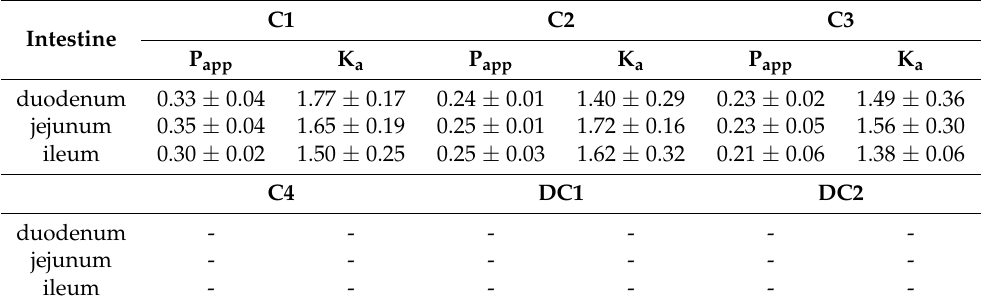
Table 1. P app and K a of C1, C2, C3, C4, DC1, and DC2 obtained from in situ single-pass perfusion administrated in their monomer forms ( n = 5).